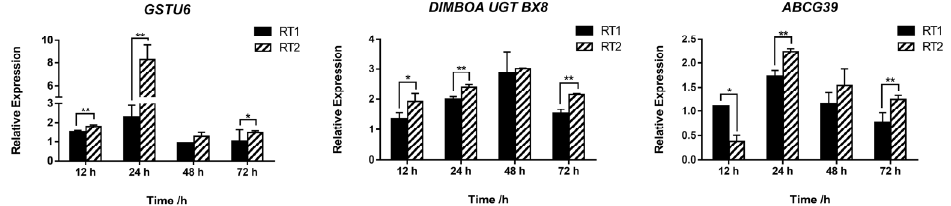
Figure 6. Effect of safener on the expression pattern of key genes. RT1: FE 45 g a.i. ha − 1 of 9311, RT2: FE 45 g a.i. ha − 1 +IH 180 g a.i. ha − 1 of 9311, and the controls were all RCK. The gene expression levels were measured using the 2 − ∆∆ Ct method. Values represent the averages of three replication, and the error bars represent standard errors. Asterisks indicate statistically significant differences between the two treatments according to Duncan’s test (*: p ≤ 0.05; **: p ≤ 0.01).